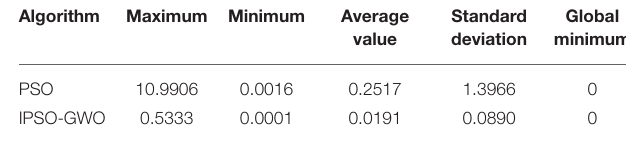
TABLE 3 | Peaks function test results.